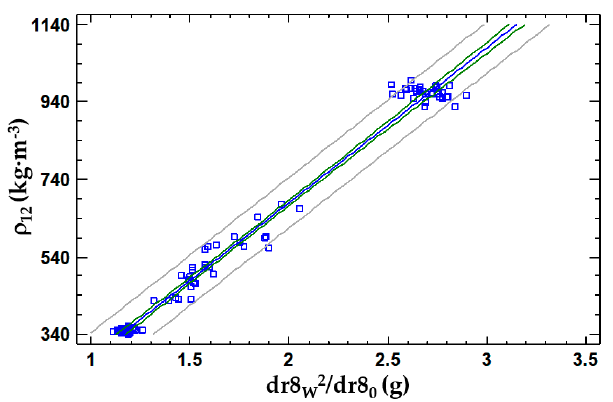
Figure 8. Linear regression model of the density of the specimen adjusted at 12% MC according to dr8 w and dr8 0 .